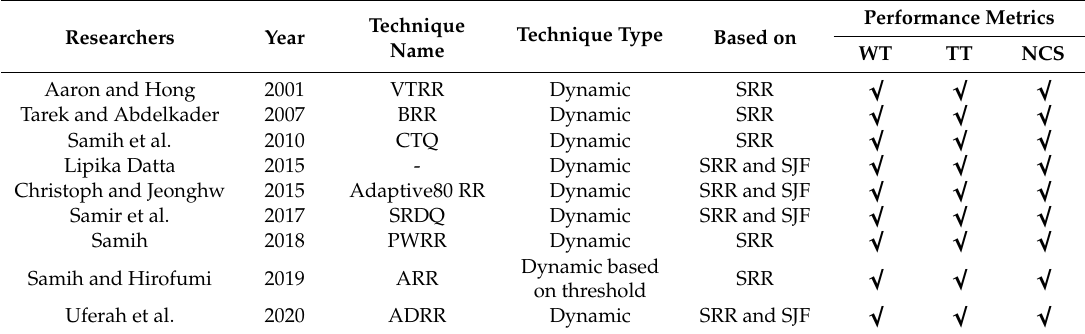
Table 2. Comparison of common versions of Round Robin (RR) (WT is acronym for waiting time, TT is acronym for turnaround